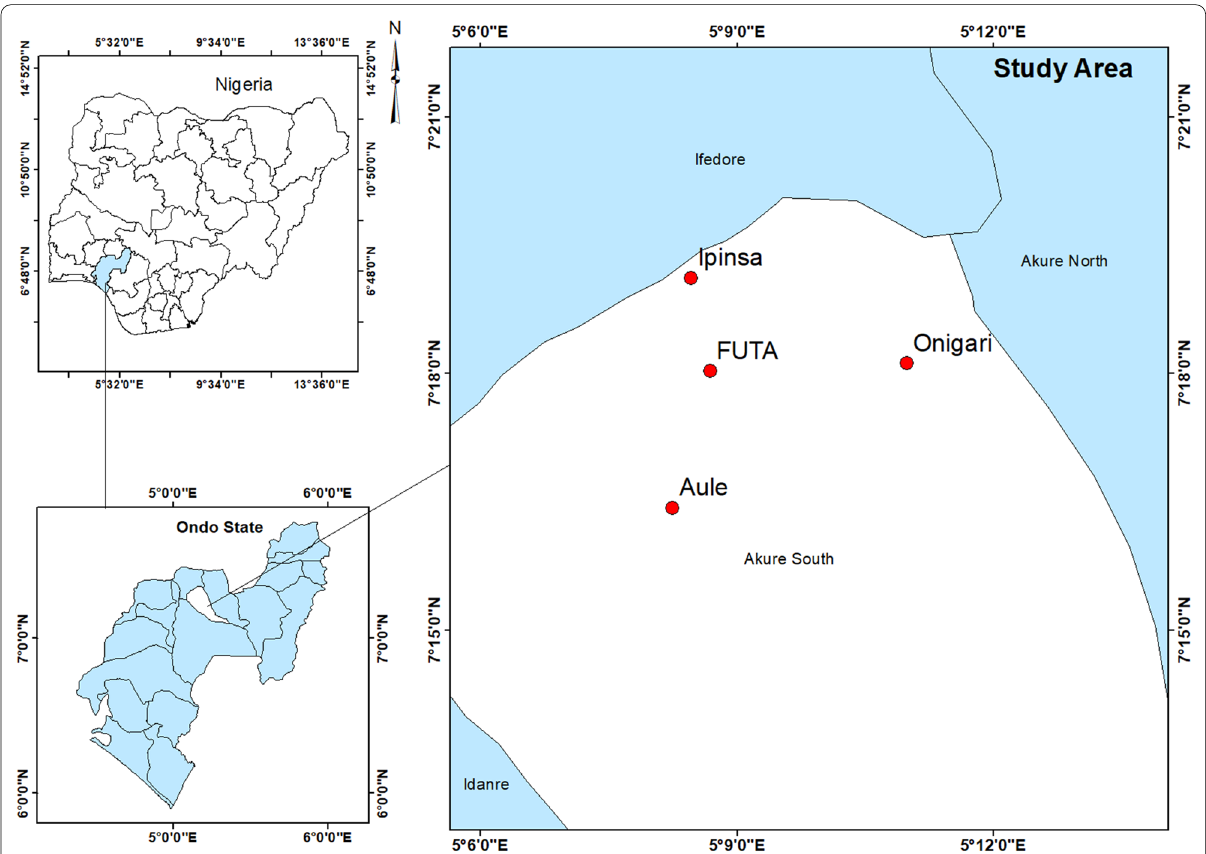
Fig. 1 Map showing the study